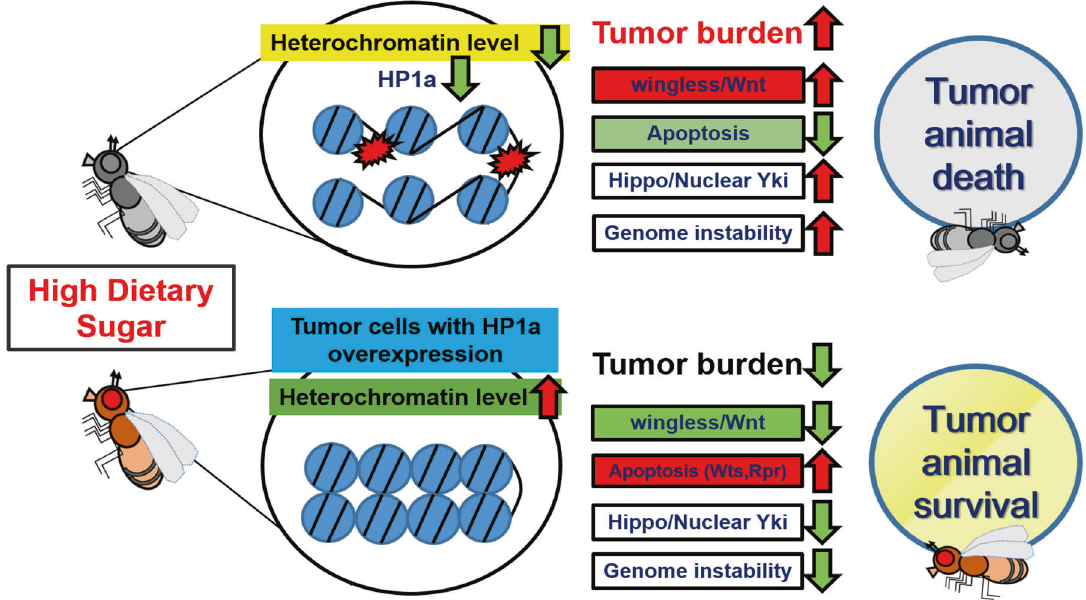
Fig. 8 Heterochromatin formation suppresses HDS-induced tumor progression by downregulating wingless/Wnt and Hippo signaling, increasing apoptosis, and maintaining genome stability. Under conditions of HDS, increasing HP1a-mediated heterochromatin formation in tumor cells can decrease tumor burden and increase survival of tumor-bearing fl ies. Moreover, HDS reduces heterochromatin formation in tumor cells. Mechanistically, heterochromatin formation suppresses HDS-induced tumor progression by decreasing wingless expression and nuclear Yki accumulation, inducing apoptosis and maintaining genome